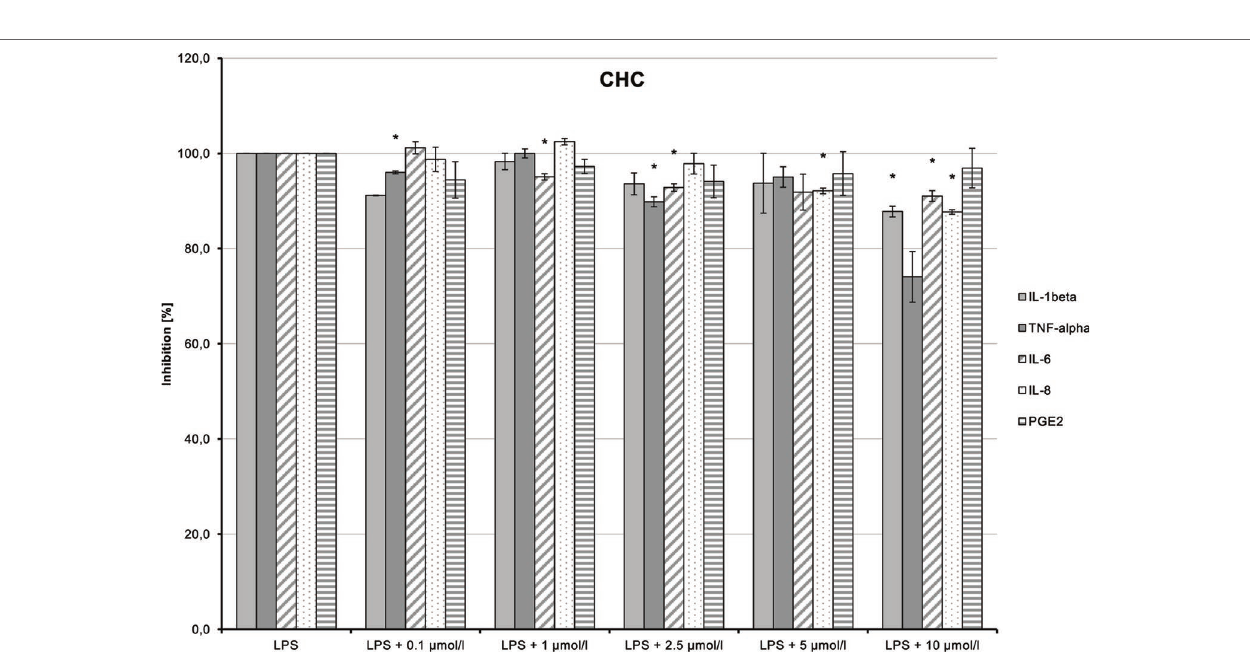
FigURE 14 | Anti‑inflammatory effect of cyclohexyl cannabidiolate (CHC) on primary human monocytes; normalized to the induction by lipopolysaccharide (LPS) (without the addition of test compounds); n = 2 independent experiments; error bars show SEM, * p < 0.1.